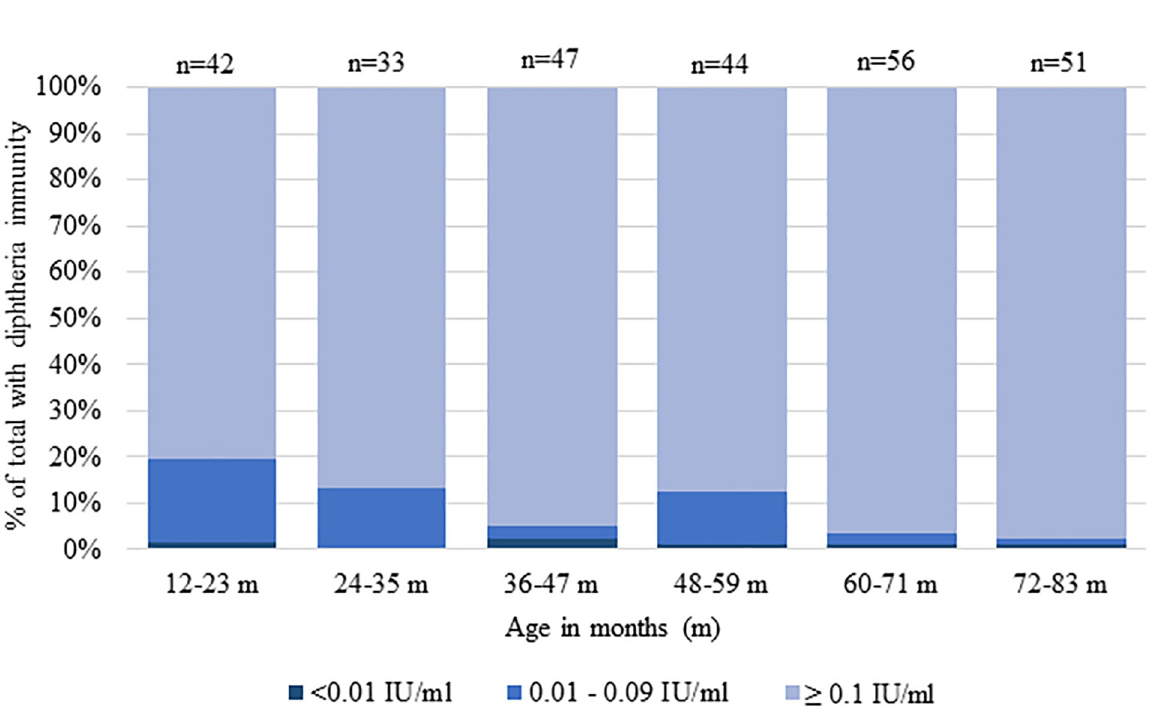
Fig 4. Diphtheria antibody levels in Nayapara by age category, serologic and vaccination coverage survey, Cox’s Bazar among Rohingya children, Bangladesh, 2018. IU, international units.